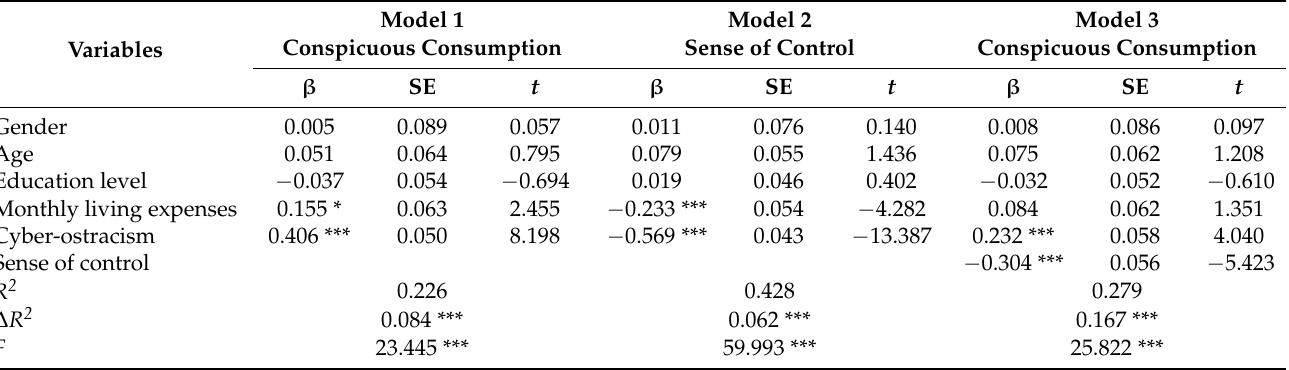
Table 6. Results of the hierarchical regression